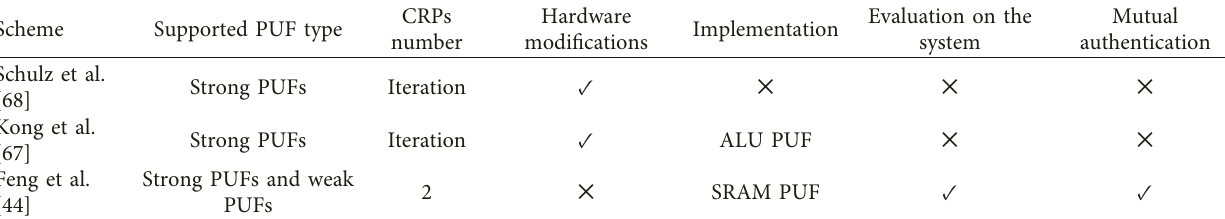
Table 10: Comparison of evaluation